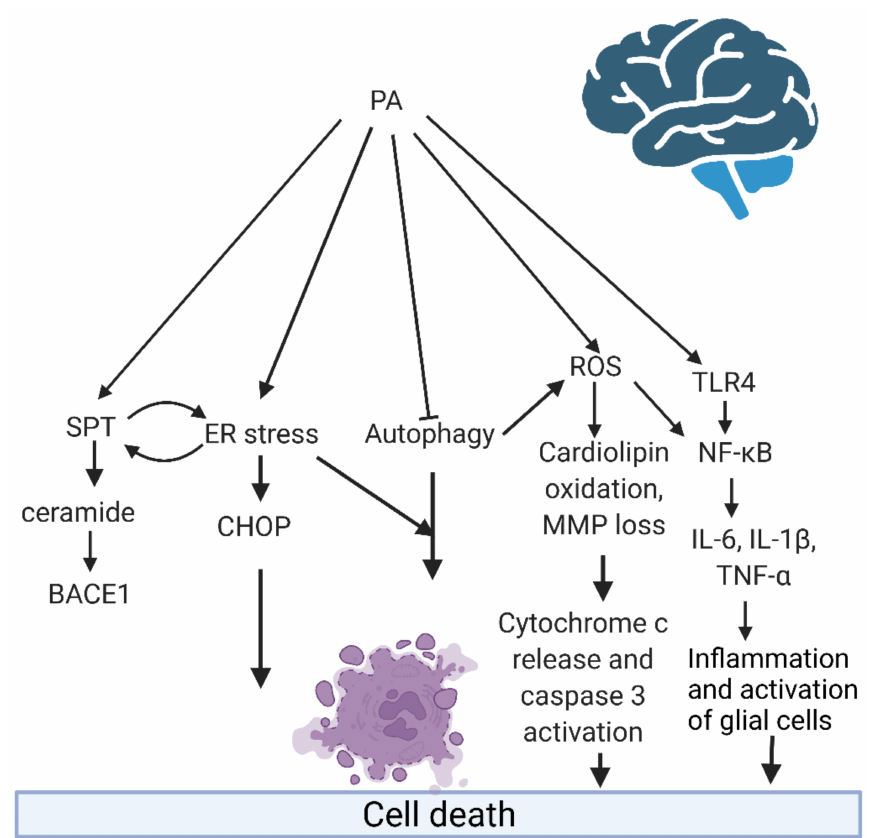
Figure 2. Common mechanisms induced by PA in the brain. Graphical summary of the common pathways in the different brain cells that promote cell damage after the exposition to toxic concen- trations of PA explained in Section 4. This figure collects and highlights the common pathways that are reported the most to produce damage in brain cells, showing that the formation of ceramides is also linked to ER stress and the reduction of autophagy that will be derived on the activation of apoptotic pathways and is potentiated by ER stress. Furthermore, autophagy impairment increases ROS production and ROS increase, and the activation of pro-inflammatory pathways are linked. These are the most frequently reported mechanisms that will induce a deleterious effect in the brain. Created with